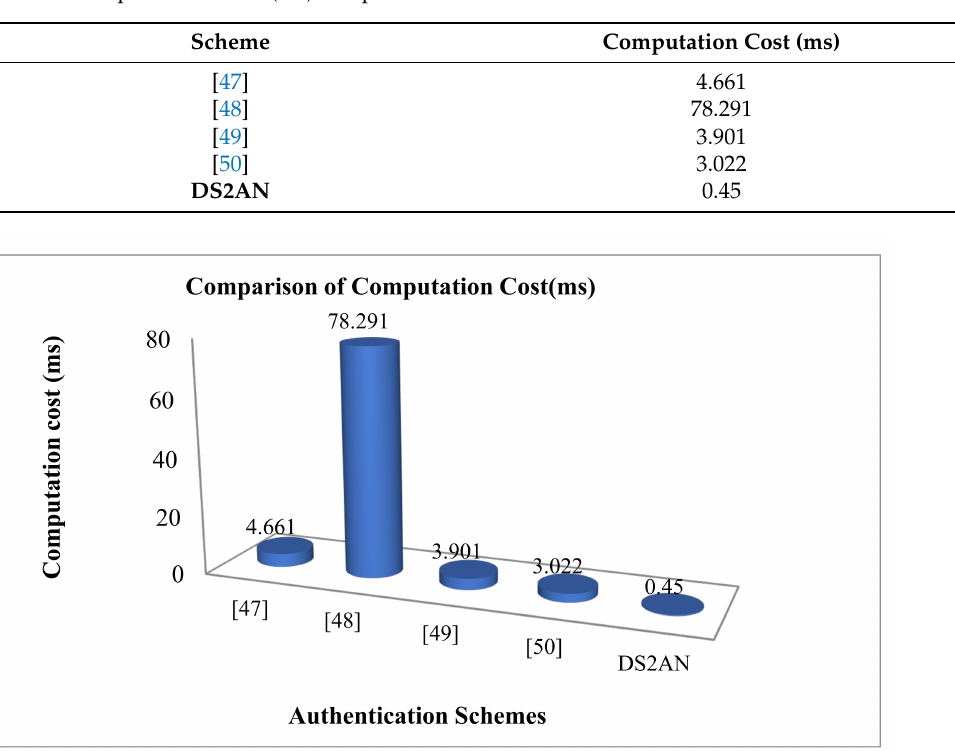
Table 8. Computational cost (ms) comparison.